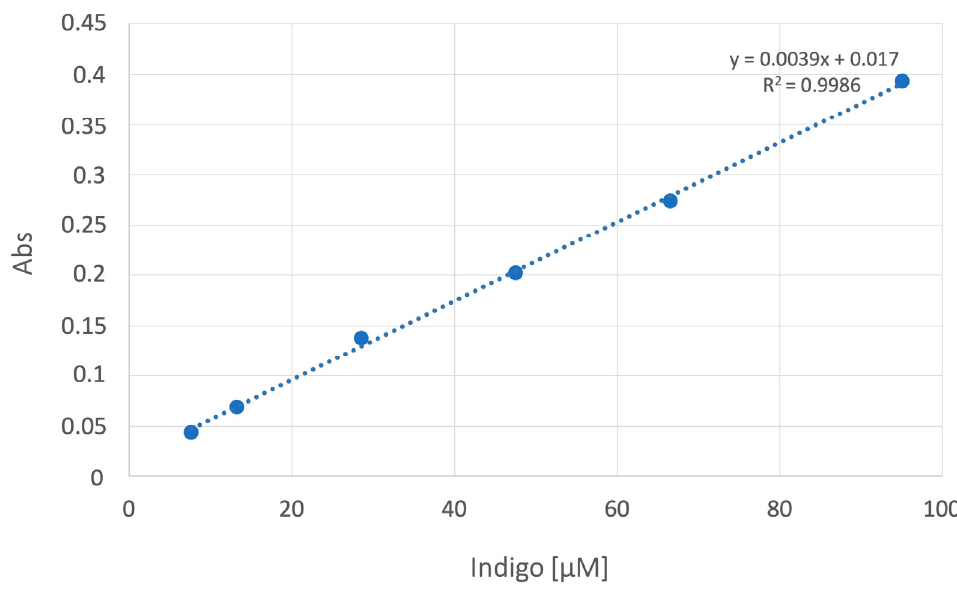
Figure 2. Calibration curve. The linear correlation between absorbance and Indigo concentrations was between 7.5 and 95 µM. Regression analysis showed R 2 ≥ 0.99.